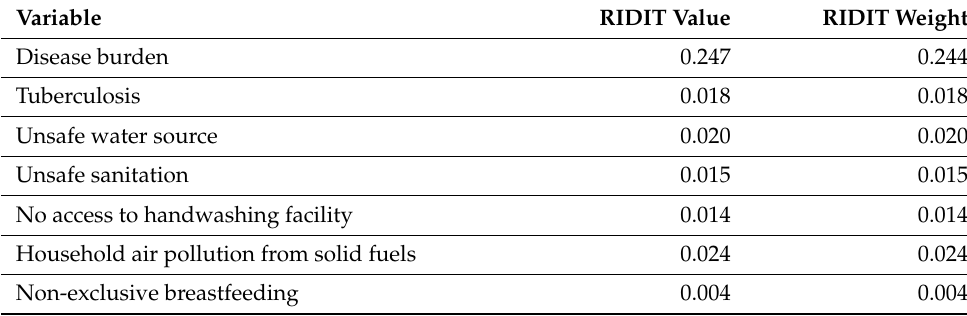
Table 5. Results of RIDIT